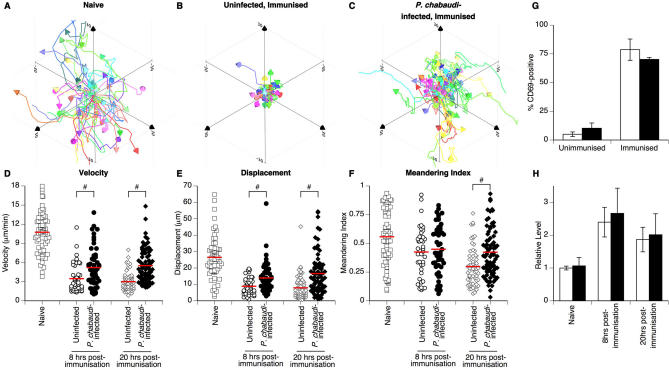
Altered T Cell Motility during Malaria InfectionBALB/c mice were infected with 106
P. chabaudi AS-infected erythrocytes i.p. Twelve days later, infected mice and uninfected groups received CFSE-labelled DO11.10 T cells and were challenged with OVA/LPS intravenously (B and C). Control animals remained unimmunised (A). T cell motility in LNs was imaged by multiphoton microscopy 8 and 20 h later. T cell behaviour was analysed using Volocity software and the tracks of several individual cells plotted (A–C) (full sequences available as Videos S9–S11). The mean velocity (D), displacement (E), and meandering index (F) of cells from multiple samples from multiple mice were also calculated. Mean and median values are represented by the red and black lines, respectively. Expression of CD69 on OVA-specific CD4+ T cells was assessed 20 h after immunisation of uninfected (empty bars) or P. chabaudi–infected (filled bars) animals (G). Antigen presentation was assessed following immunisation of uninfected (empty bars) or P. chabaudi–infected (filled bars) C57BL/6 mice with 500 μg Eα-GFP + 50 ng LPS intravenously YAe staining on CD11c+ splenic DCs was assessed 8 and 20 h after immunisation. Data shown are representative of three similar experiments (# p < 0.05 uninfected, OVA-immunised versus P. chabaudi–infected, OVA-immunised).